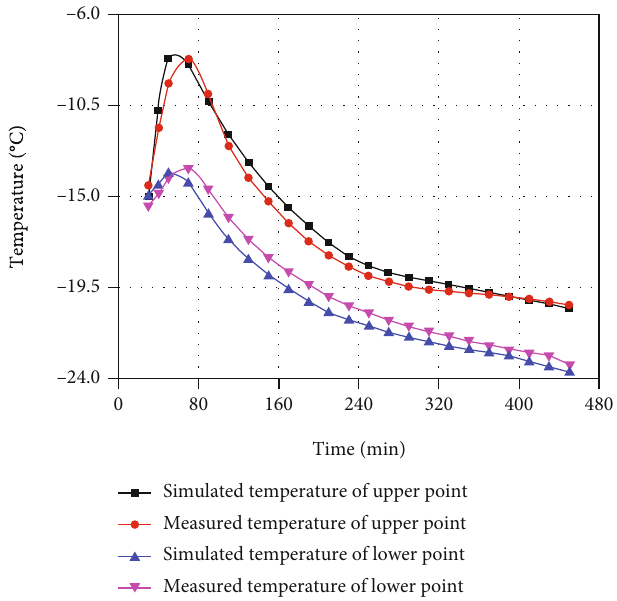
Figure 9: Simulated and measured temperature changes at the two measurement